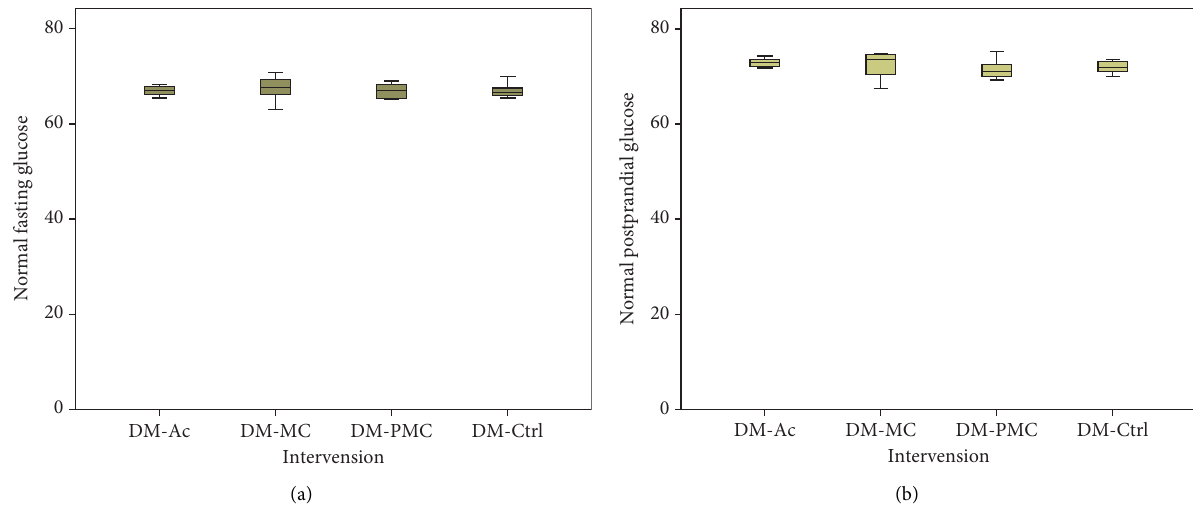
Figure 1: Baseline normal blood glucose: (a) fasting blood glucose; (b) postprandial blood glucose.